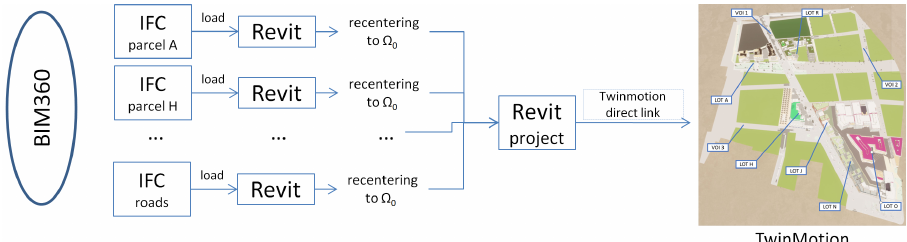
Figure 9. Workflow of the construction of the TwinMotion